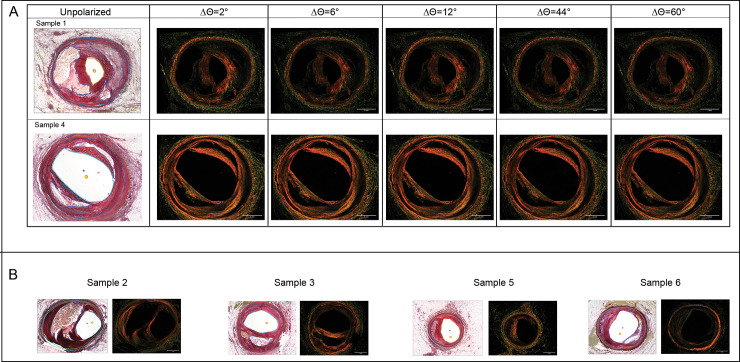
Unpolarized image and corresponding polarized co-registered composite images from different Δϴ.(A) First row and second rows correspond to an example of a section with a thick collagen cap (124μm) and thin cap (43μm), respectively. (B) Unpolarized and corresponding polarized composite images (Δϴ = 60°) of other samples for angle of rotation analysis. Scale bars = 1 mm.